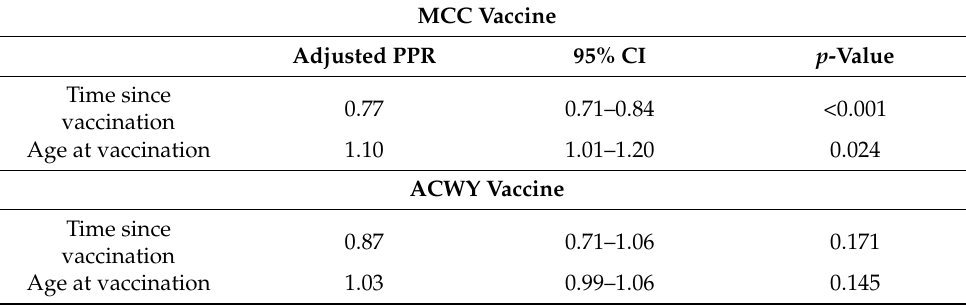
Table 2. Multivariable analysis of factors affecting protective response (rSBA titres ≥ 1:8) after MCC